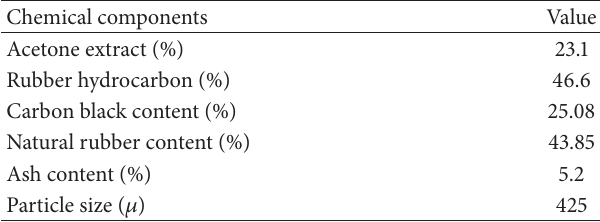
Table 6: Chemical components of CRM number 40 (ASTM D297). Chemical components